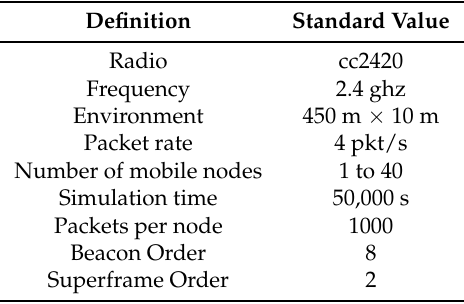
Table 1. Simulation configuration.